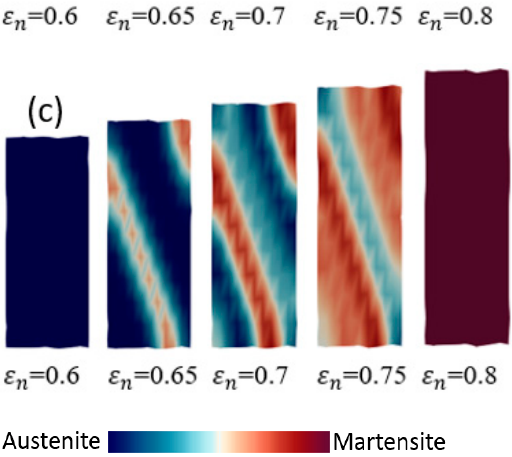
Figure 19. The distribution of the martensitic phase of single crystal TRIP steel with different cell sizes ( a ) 0.1 × 0.1 mm, ( b ) 0.5 × 0.5 mm, and ( c ) 1.0 × 1.0 mm.